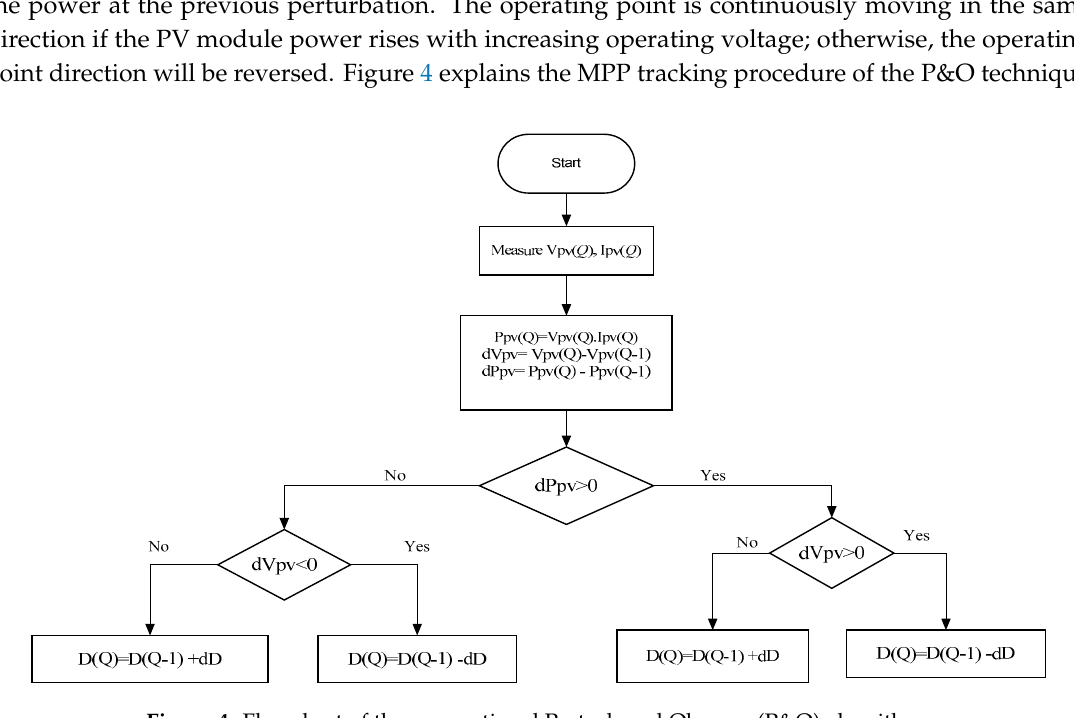
Figure 4. Flowchart of the conventional Perturb and Observe (P&O) algorithm.